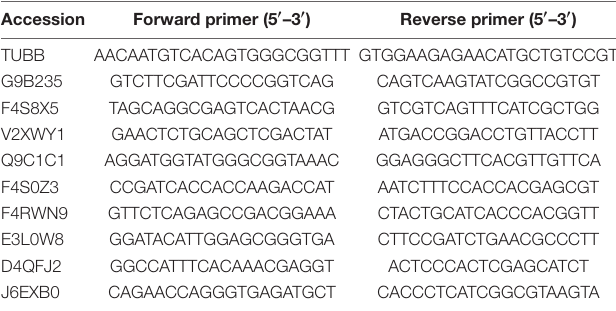
TABLE 1 | Sequences of the primers used for real-time fluorescence quantitative PCR